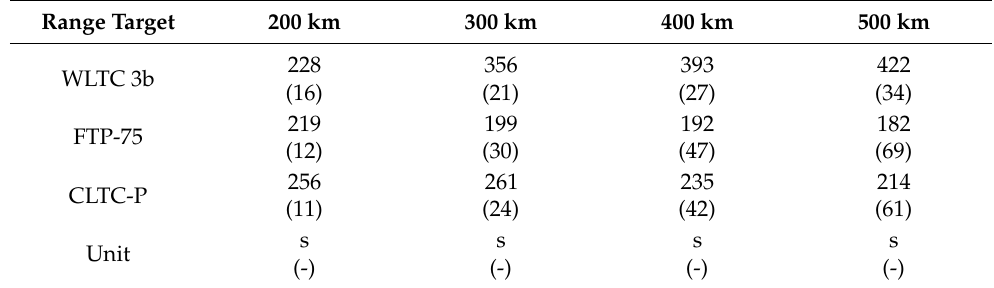
Table A4. Average REX single instance running time and the total number of engagements (in parentheses) for four range targets in WLTC 3b, FTP-75, and CLTC-P drive cycles. Vehicle mass is 2100 kg.